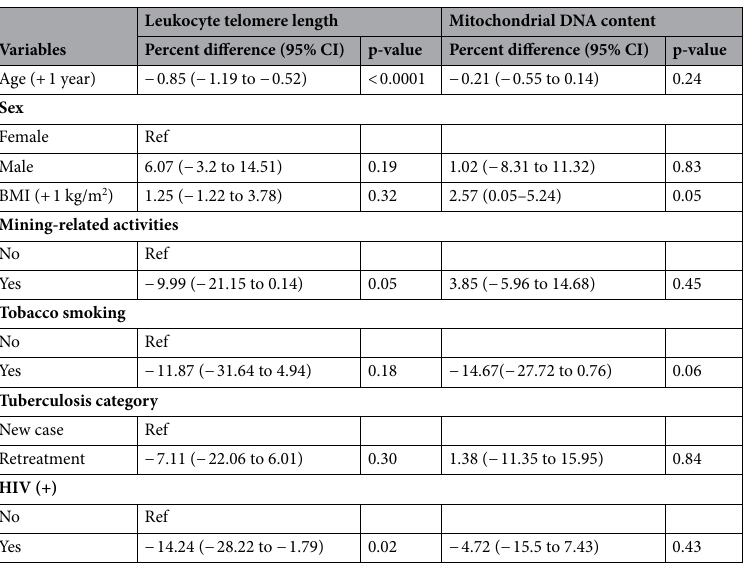
Table 3. Multivariable linear regression analysis of predictors for biomarkers of ageing among patients with pulmonary tuberculosis. All models are adjusted for sociodemographic (age, gender, etc.) and clinical variables (BMI, HIV status, smoking history, mining related activity status). BMI body mass index, Ref.